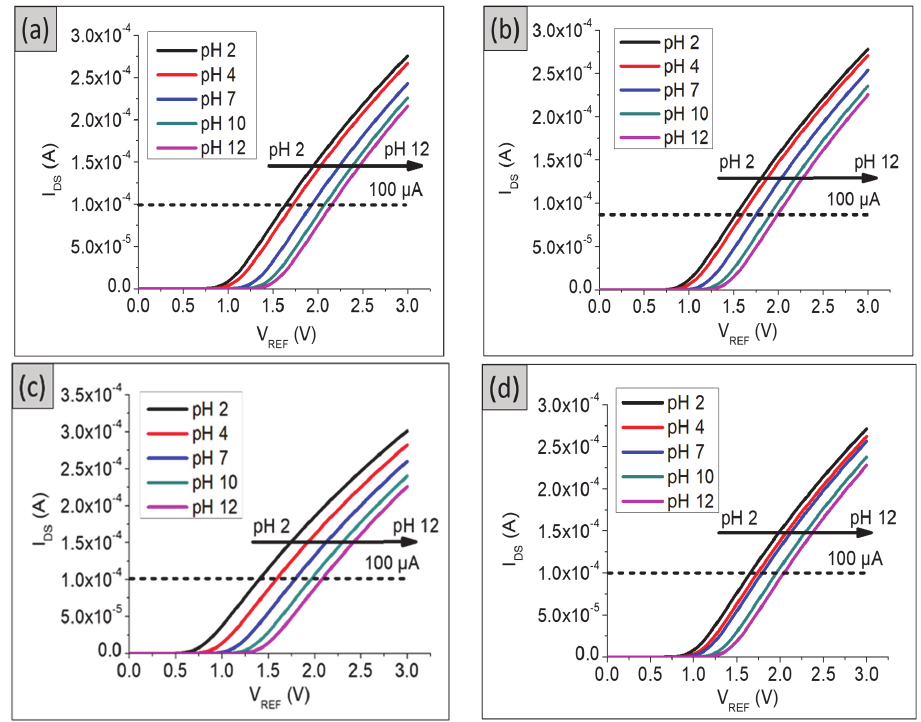
Figure 3. Transfer characteristics (I DS –V REF) in linear region for ( a ) TiO 2 thin film, ( b ) TiO 2 –PANI bilayer composite thin film, ( c ) TiO 2 –PANI composite thin film, and ( d ) ITO substrate.